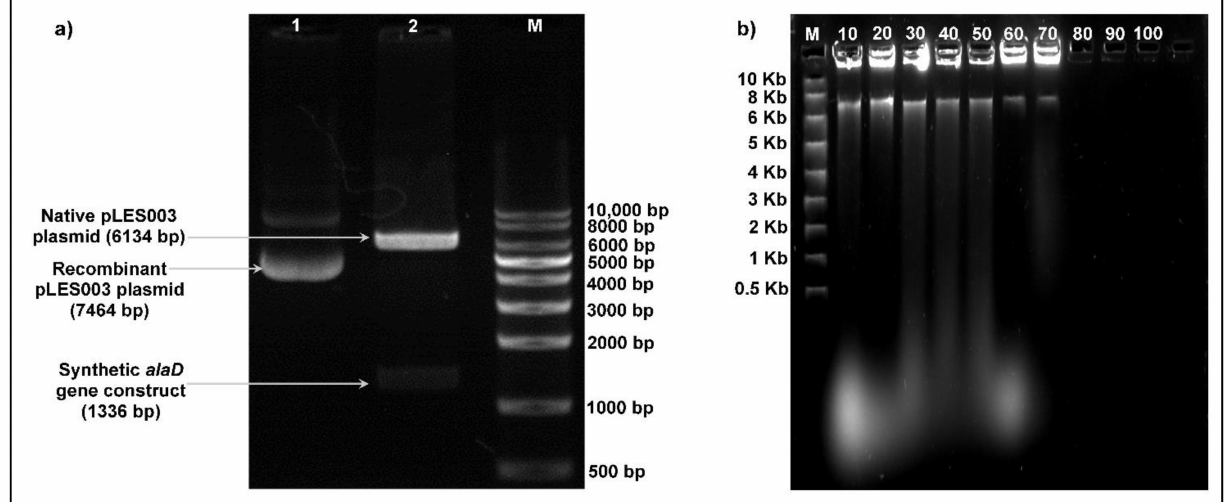
Figure 2. ( a ) Gel analysis of the recombinant pLES003 alaD vector, where Lane 1 shows the recombinant pLES003 alaD vector, Lane 2 shows the EcoRI linearized recombinant pLES003 alaD and Lane M shows the DNA ladder. ( b ) Segregational stability of the recombinant pLES003 alaD (7464 bp) analyzed on 1% w / v agarose gels, where Lane M shows the DNA ladder and Lanes 10–100 show the number of subculturings for which the stability of the recombinant plasmid was